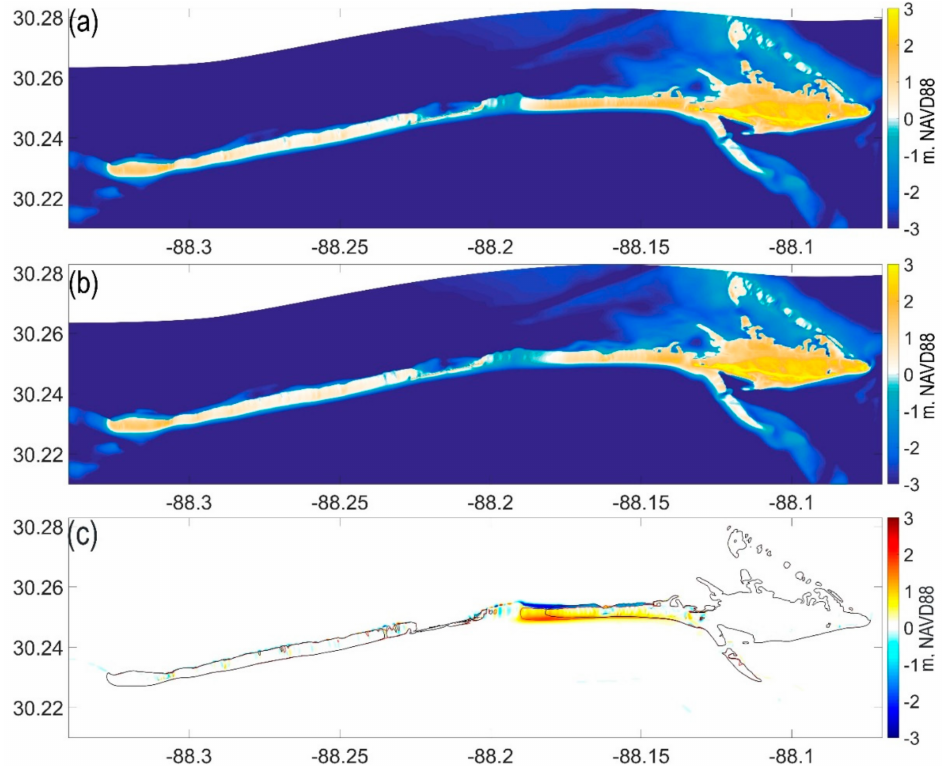
Figure 7. Post-storm 191 bed level elevations for the ( a ) nourishment scenario, ( b ) no action scenario and ( c ) difference between nourishment and no-action scenarios. In ( c ), the black line is the 0 m contour for final (Year 30) no-action scenario and the red line is the 0 m contour for the final (Year 30) nourishment